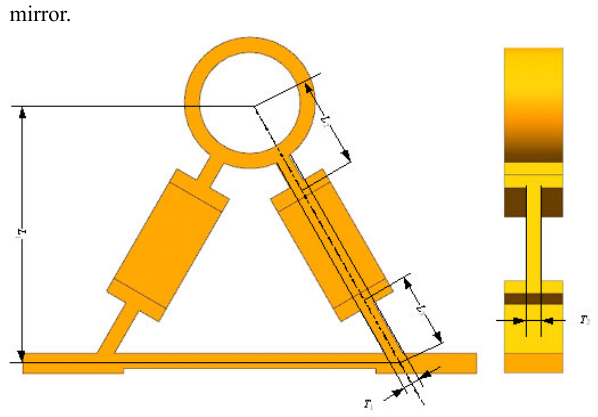
Fig. 9 Each parameter of the flexure